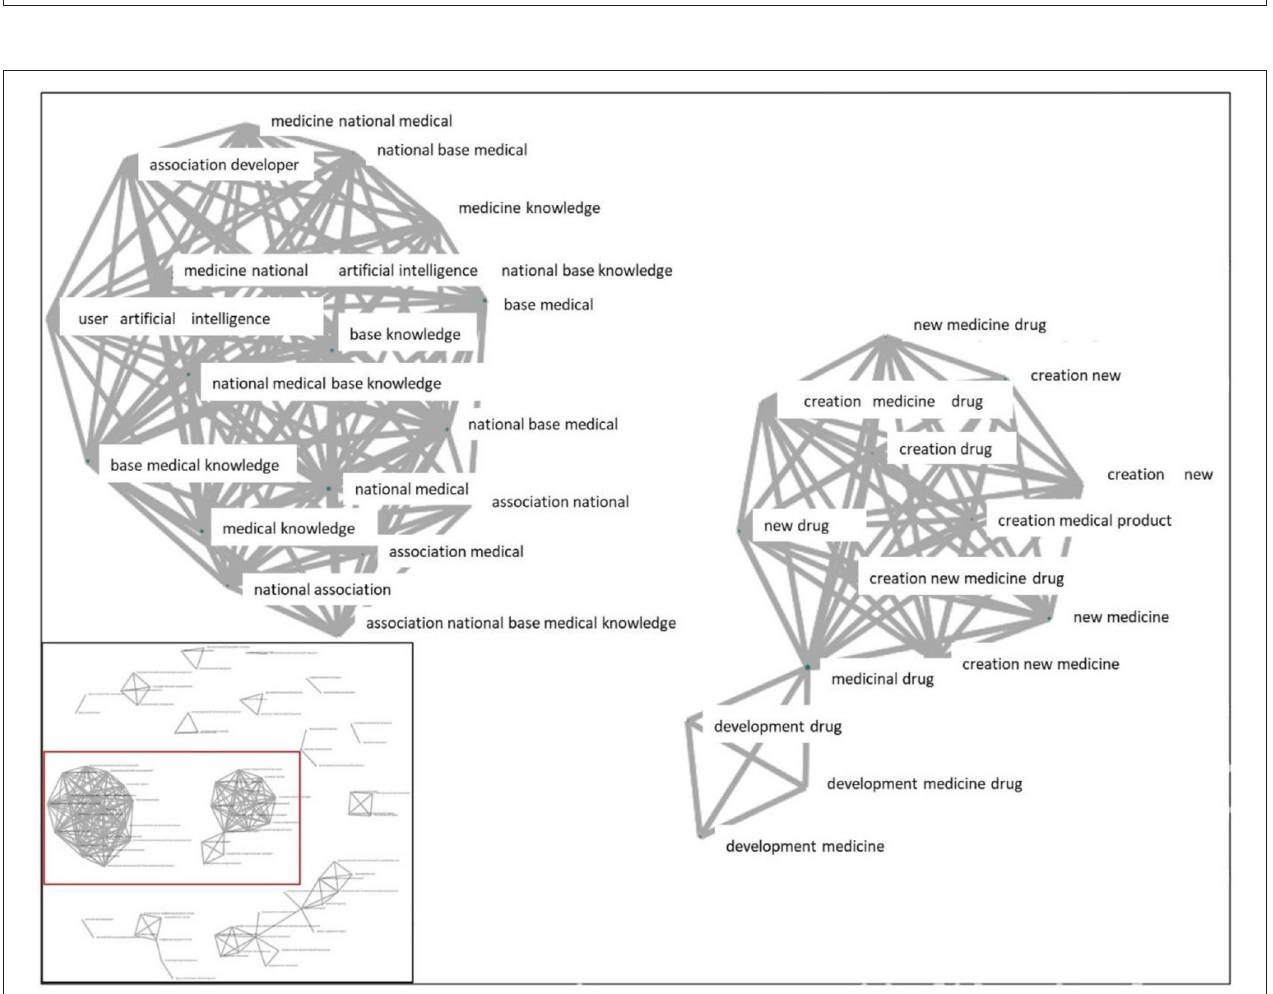
FIGURE 4 | Keyphrase visualization for NTI websites: link frequency p > 10, fragment (2017–2019).